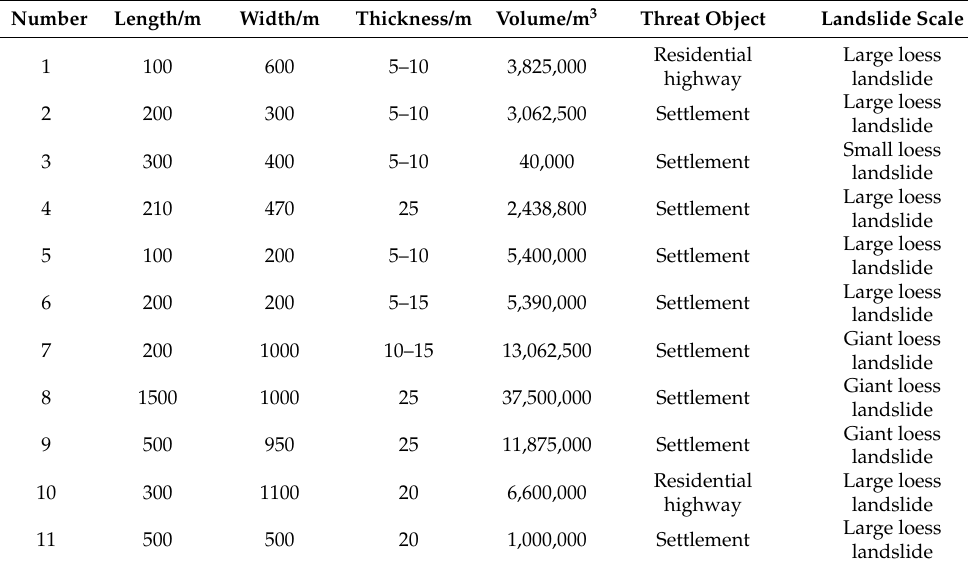
Table 2. Statistical information table for identifying landslide points.